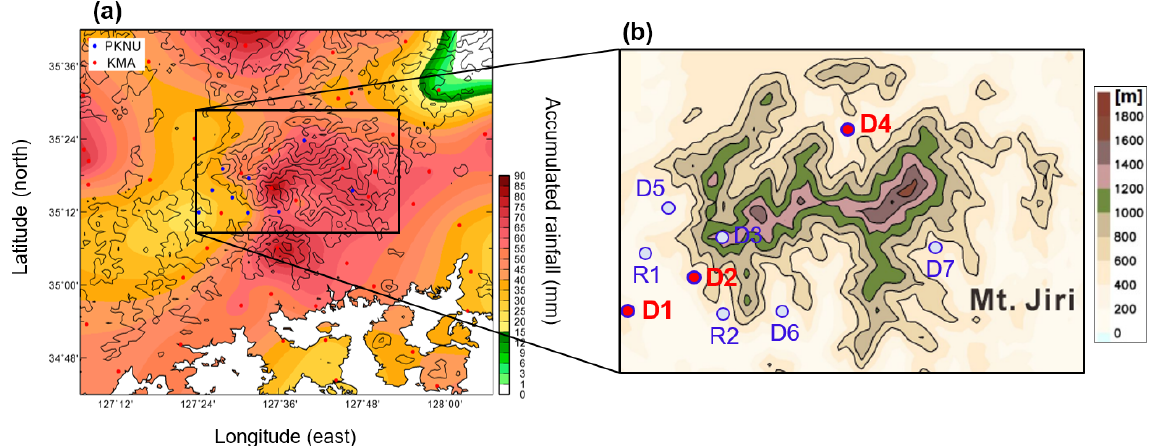
Figure 4. (a) Distribution of an accumulated rainfall (mm) on 1 July over contours of altitude at 300m interval and (b) the enlarged topography of Mt. Jiri with contours of altitude at 200m interval, showing nine observation sites. Three sites in red are where the Parsivel and UVW measurements were analyzed in this study. R1 and R2 show sites with a rain gauge only.